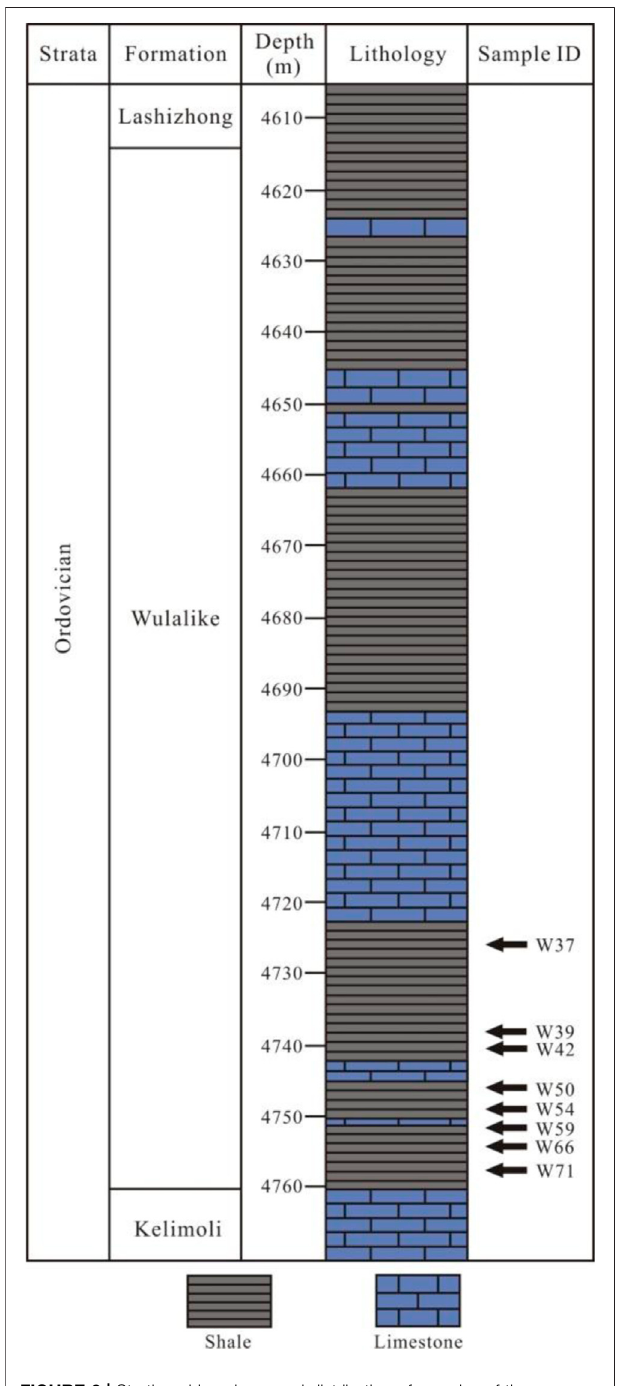
FIGURE 2 | Stratigraphic column and distribution of samples of the Wulalike Formation in the Ordos Basin.